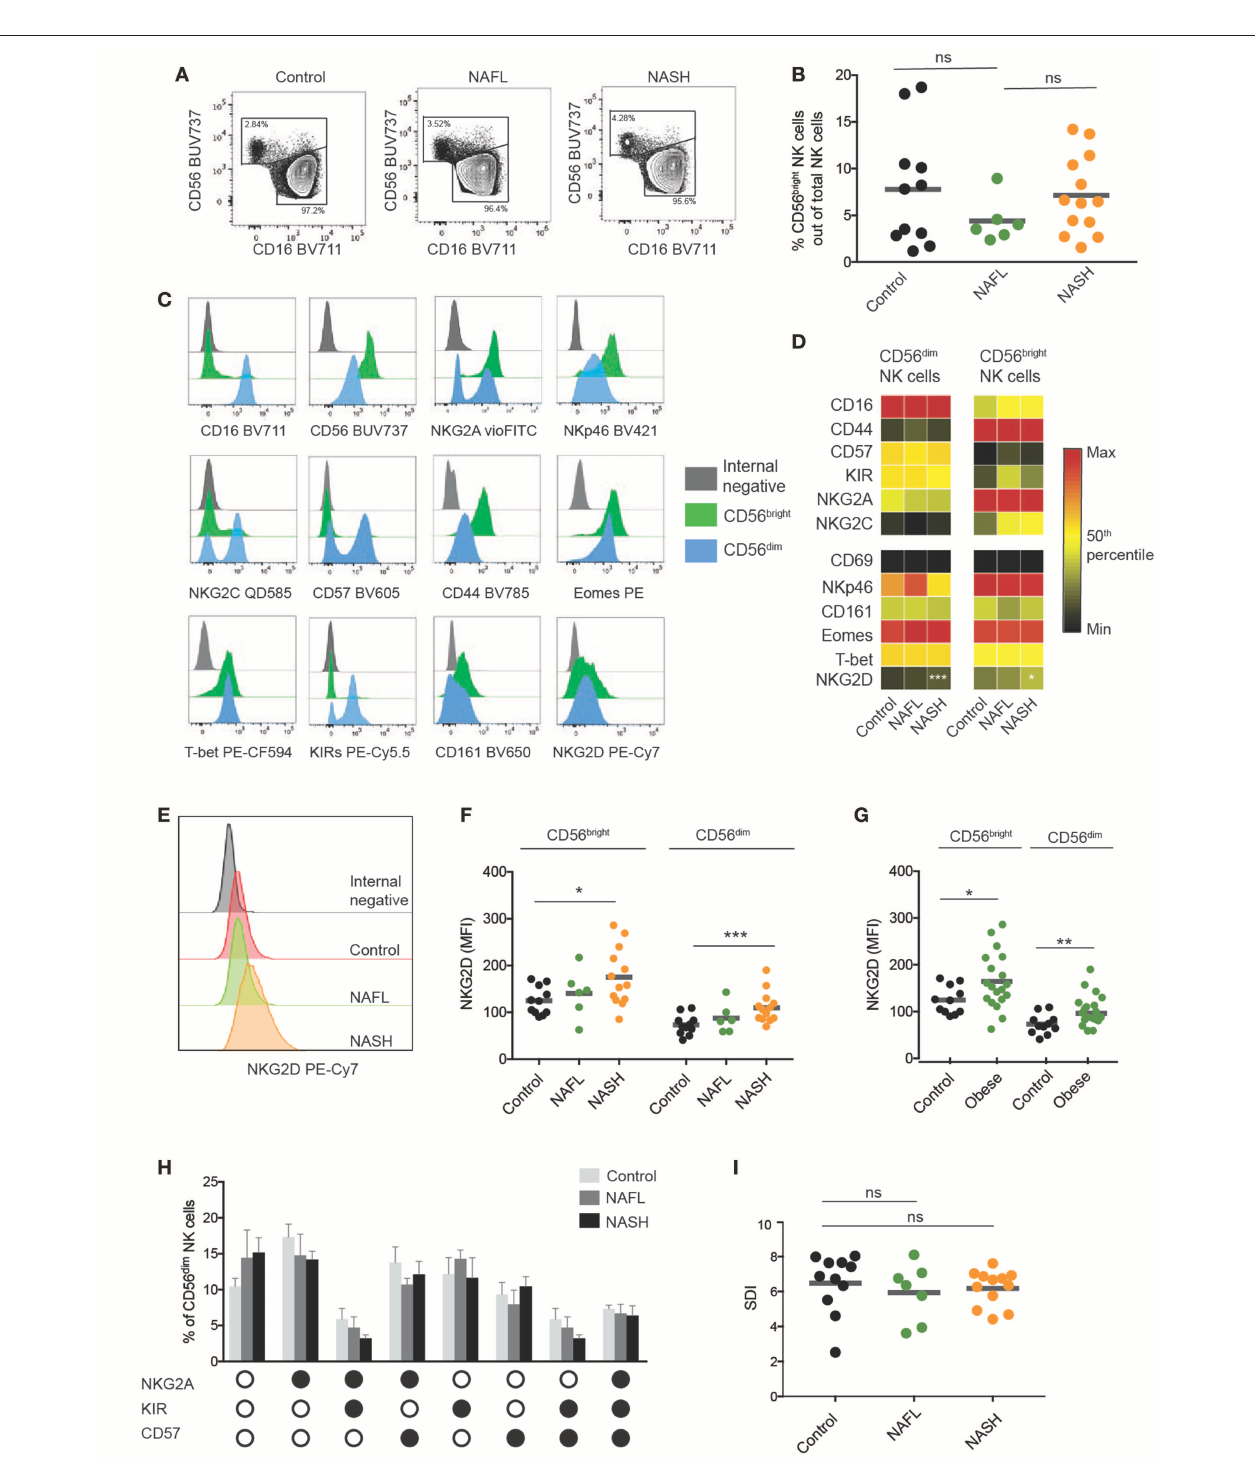
FIGURE 2 | Phenotypic characterization of circulating NK cells from NAFLD patients. (A) Representative flow cytometry plots of NK cells from healthy, NAFL, and NASH patients. (B) Frequency of CD56 bright NK cells out of total NK cells in peripheral blood of healthy controls ( n = 13), NAFL patients ( n = 9), and NASH patients ( n = 16). (C) Representative histograms for the indicated markers on CD56 bright and CD56 dim NK cells as well as internal negative control. The plots represent stainings from one healthy donor. (D) Heat map depicting the mean frequency of NK cells expressing CD16, CD44, CD57, KIRs, NKG2A, and NKG2C as well as the mean MFI of CD69, NKp46, CD161, Eomes, T-bet, and NKG2D on CD56 dim and CD56 bright NK cells for the indicated groups. (E) Representative histogram of NKG2D